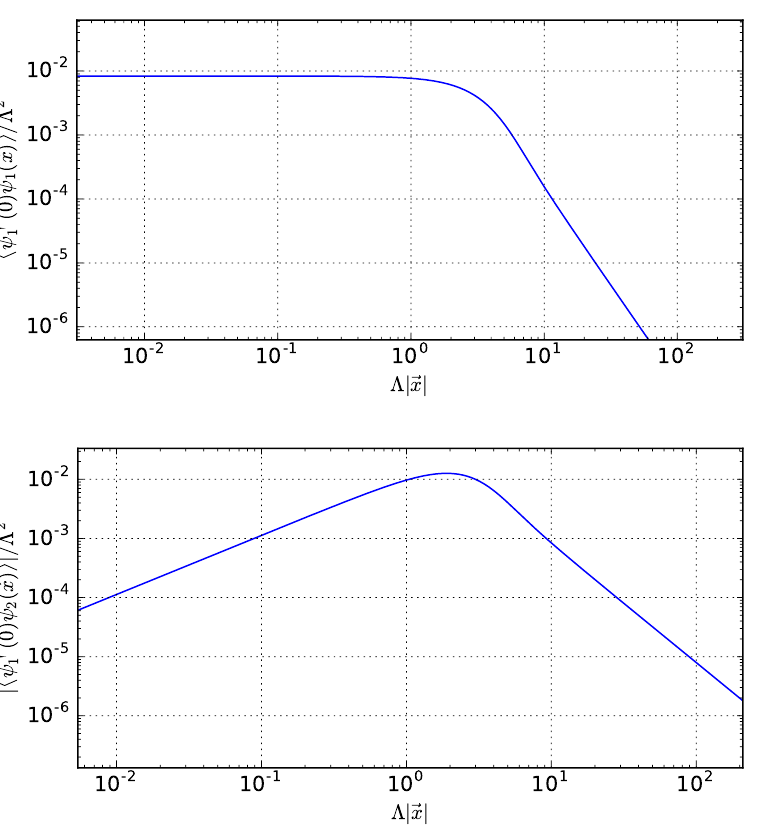
Figure 16 . Correlation functions h y and computed for the 2+1 dimensional fermionic cMERA with j =